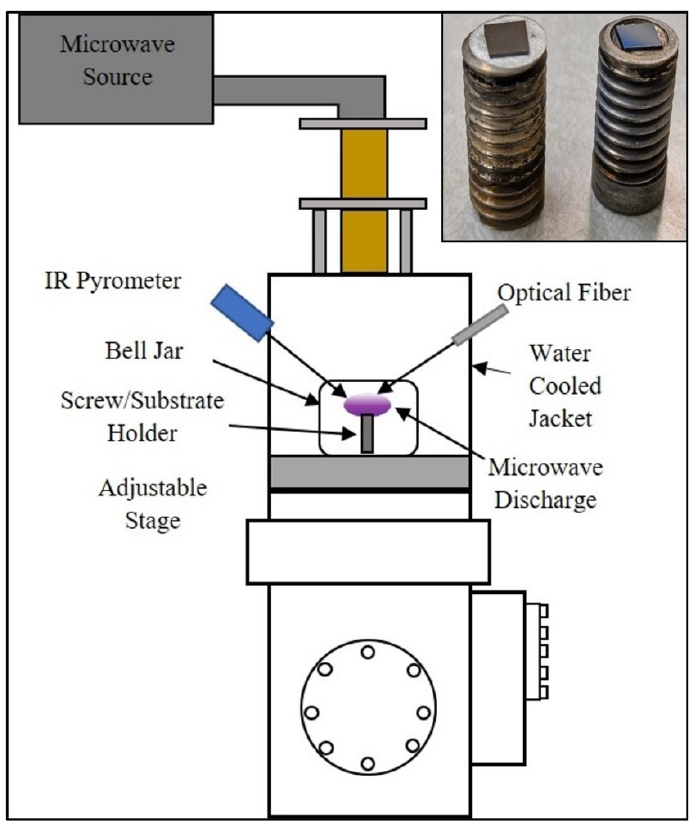
Figure 1. Schematic of the 6 kW Microwave Plasma Chemical Vapor Deposition (MPCVD) chamber showing plasma confined within a quartz bell jar. The inset shows how the substrates were placed on the substrate holder for sample BC-1 (flat screw) and BC-2 (screw with inset).